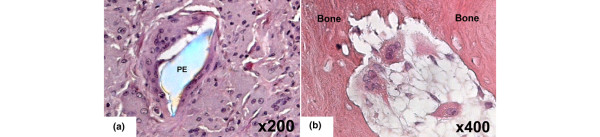
Sections of human peri-implant tissues stained by hematoxylin and eosin. (a) Multinucleated cell associated with a polyethylene (PE) wear particle. (b) Multinucleated cells line the bone surface at site of bone resorption.